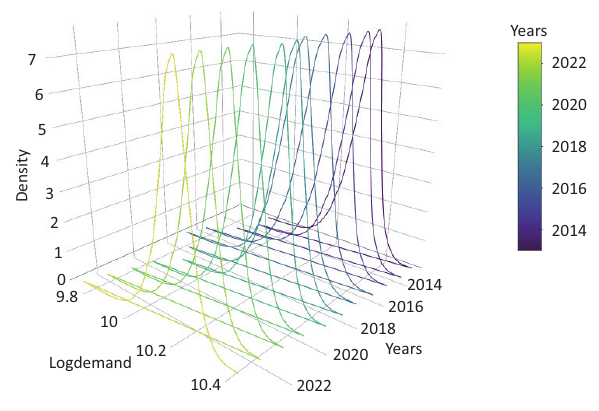
FIGURE 8: The morning peak demand